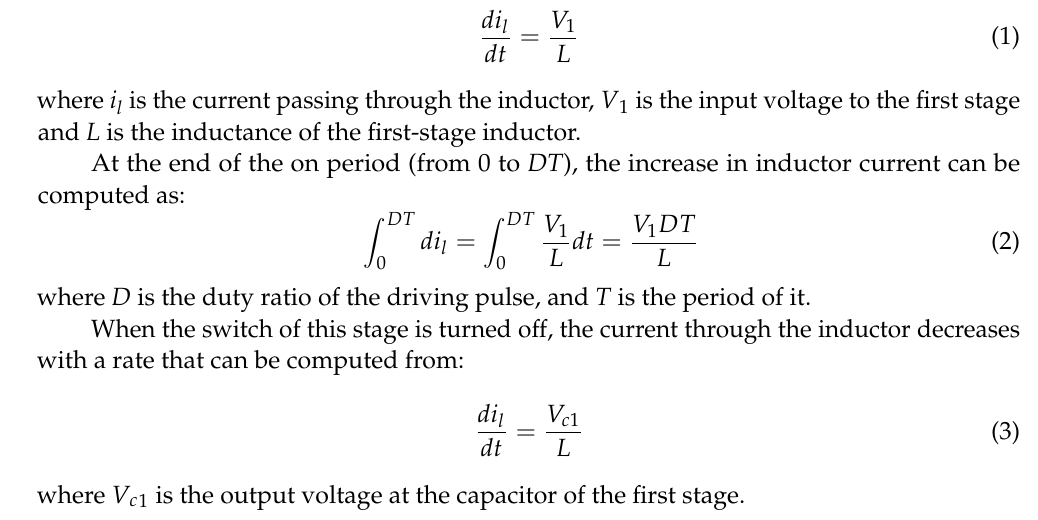
Figure 2. Modes of operation of the proposed converter: ( a ) switches are turned on; ( b ) switches are turned off; ( c ) discharge of stage capacitors through